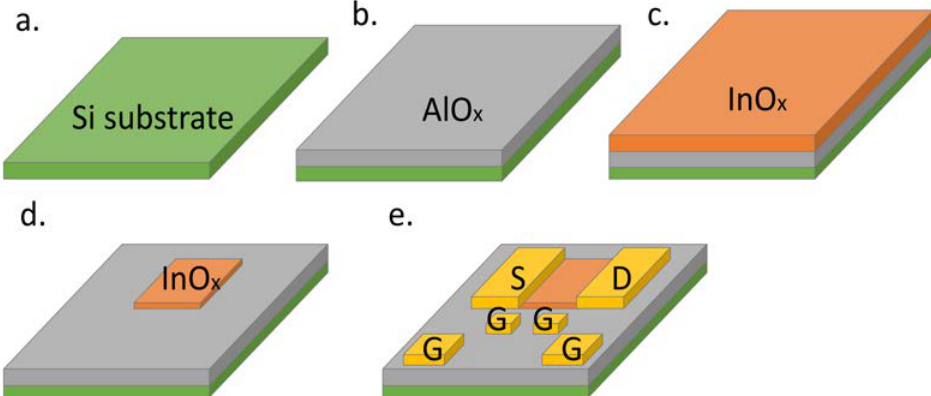
Figure 1. ( a – e ). Fabrication schematic of multi- gate artificial synaptic transistor with InO x channel and AlO x electric-double-layer (EDL) dielectric. S, D, and G represent source, drain and gate.